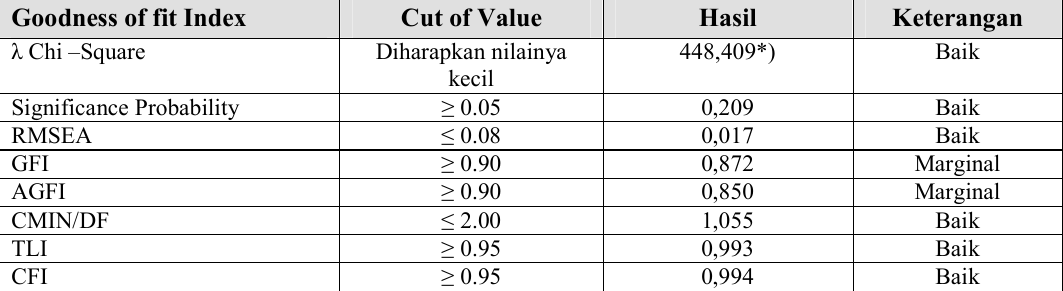
TABEL 4. I(cid:9)DEKS PE(cid:9)GUJIA(cid:9) KELAYAKA(cid:9) STRUCTURAL EQUATIO(cid:9) MODEL - MODEL EMPIRIK